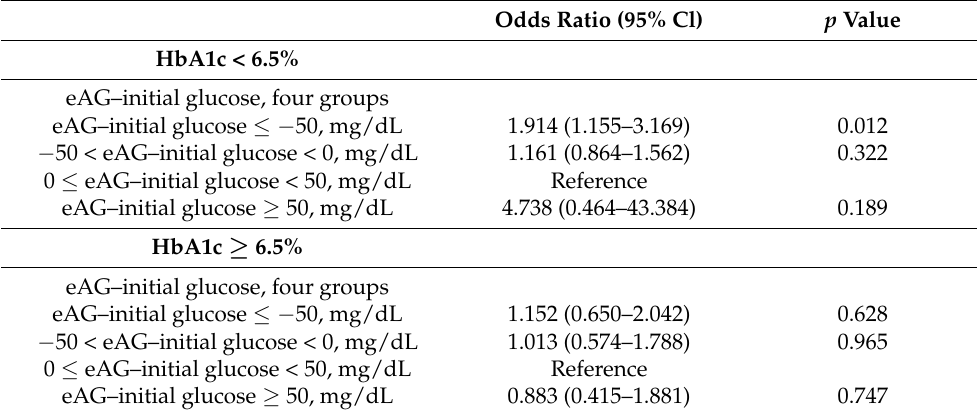
Table 4. Binary logistic-regression analysis for poor short-term functional outcomes after categoriza- tion by glycemic control status (HbA1c < 6.5% versus HbA1c ≥